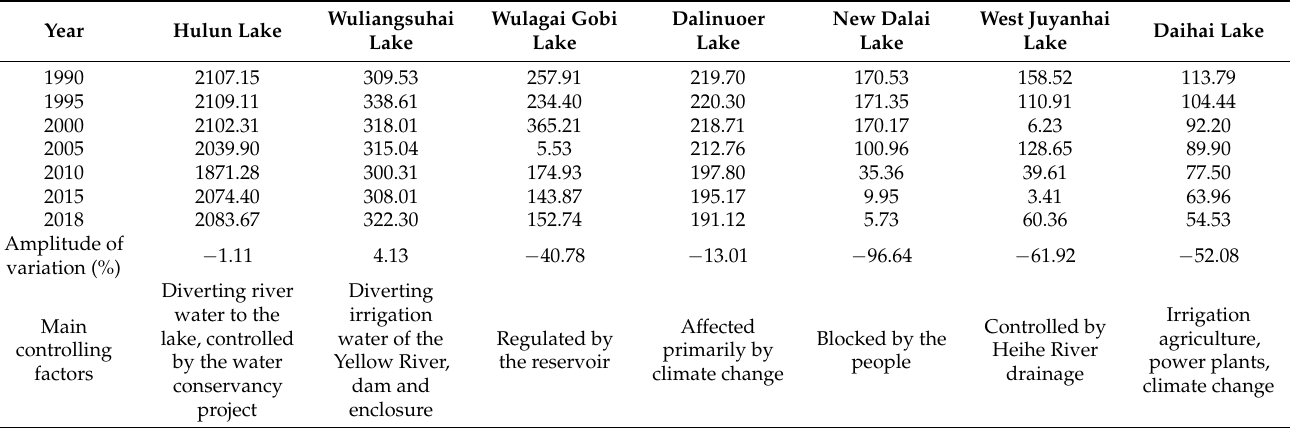
Table 6. Changes in and the major controlling factors of the lakes with individual areas of >100 km 2